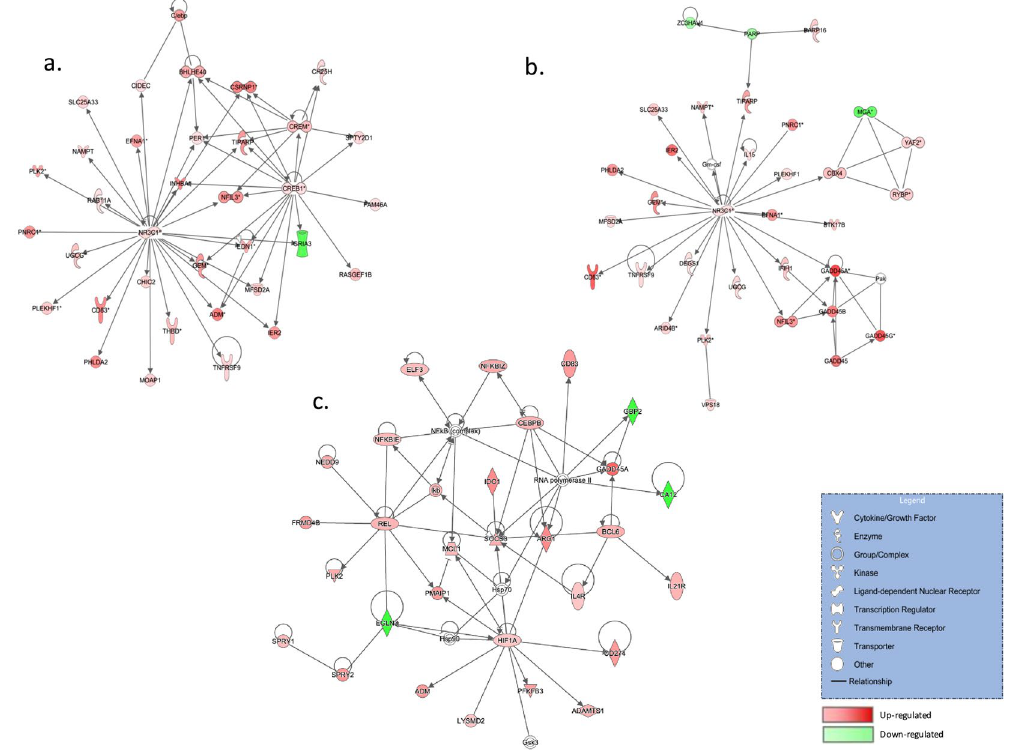
Figure 7. Network analysis for the differentially expressed genes (DEGs) in the intestine following exposure to FX or DON. To create gene networks, DEGs following exposure to FX 2 µ M ( a ), FX 10 µ M ( b ) or DON 10 µ M ( c ) were overlaid onto a global molecular network that was developed from information contained in the Ingenuity Knowledge Base. The IPA Network Generation Algorithm links genes based on experimentally observed interactions and orders these genes based on their interconnectedness. Generally, the more interactions with other network members, the more central a gene will be in a network. In the networks, the edges or arrows indicate gene interactions. Only direct interactions have been considered. Red nodes represent up-regulated genes, and green nodes represent down-regulated genes identified in our differential expression analysis. Darker node colors indicate more extreme (high or low) up- or down-regulation of the respective gene. White nodes represent genes that were not originally identified in our microarray analysis but were are predicted by IPA to be involved in the